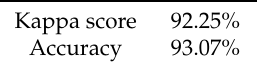
Table 2. The results of the kappa score and accuracy.